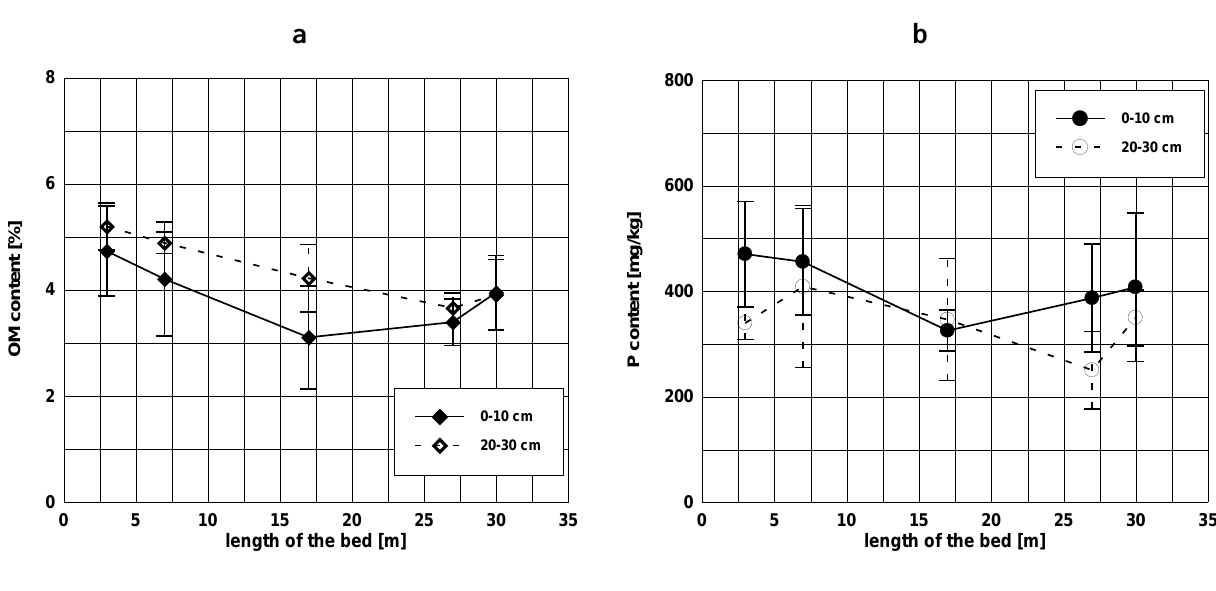
Figure 1. Changes in content of ( a ) organic matter (OM) and ( b ) phosphorus (P) in the substrate along the length of the constructed wetland treatment bed. Each point represents the mean value and standard deviation of five substrate analyses.